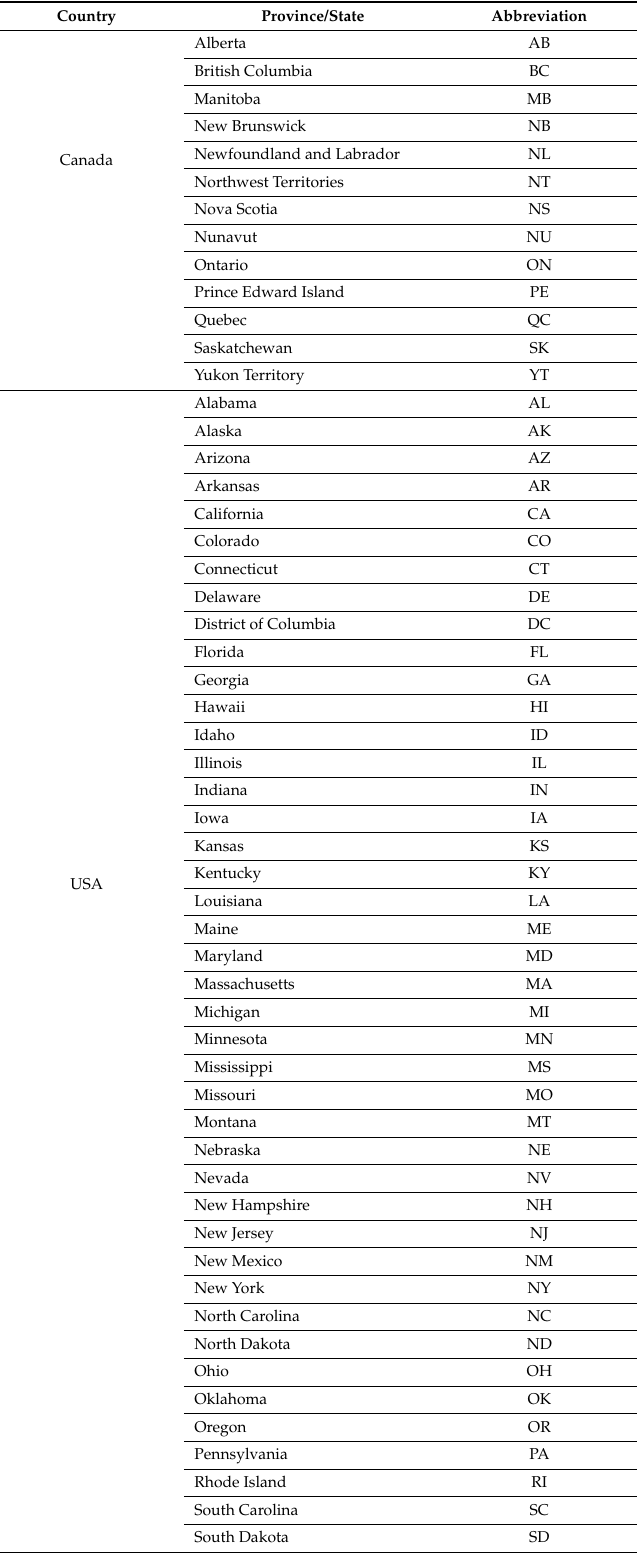
Table A1. Abbreviations for Canadian provinces and USA